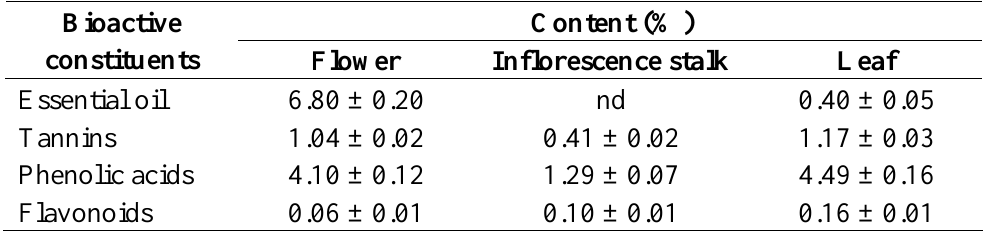
Table 1. Contents of bioactive constituents of different parts of Lavandula · intermedia